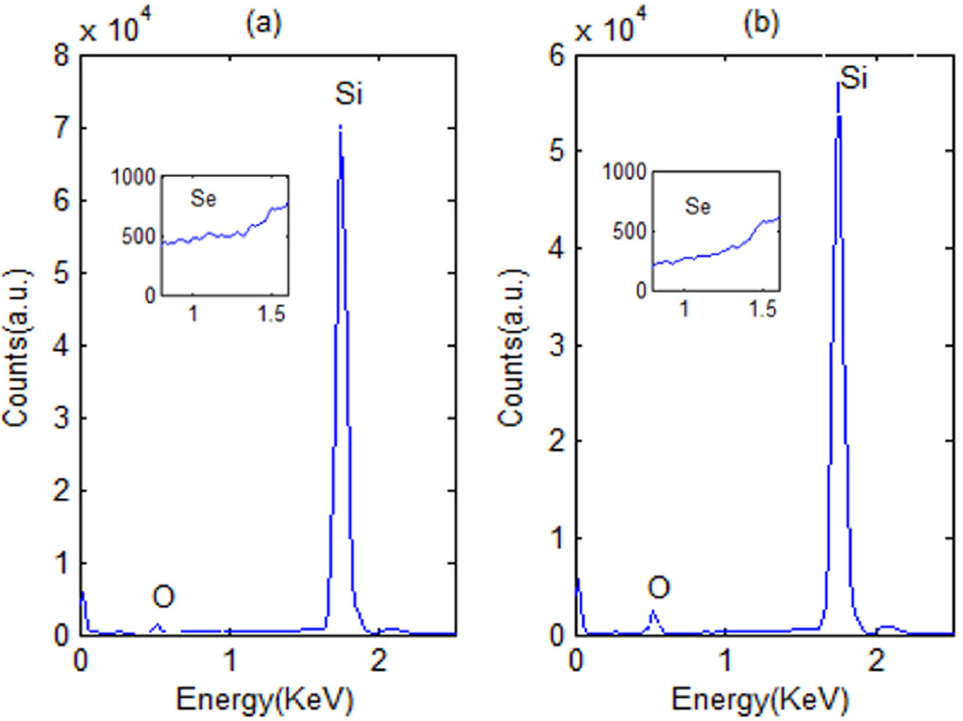
Figure 4. EDX spectral taken in black silicon microstructure (marked by the pointer in Figure 2) for ( a ) fs-laser-treated Si and ( b ) ps-laser-treated Si.